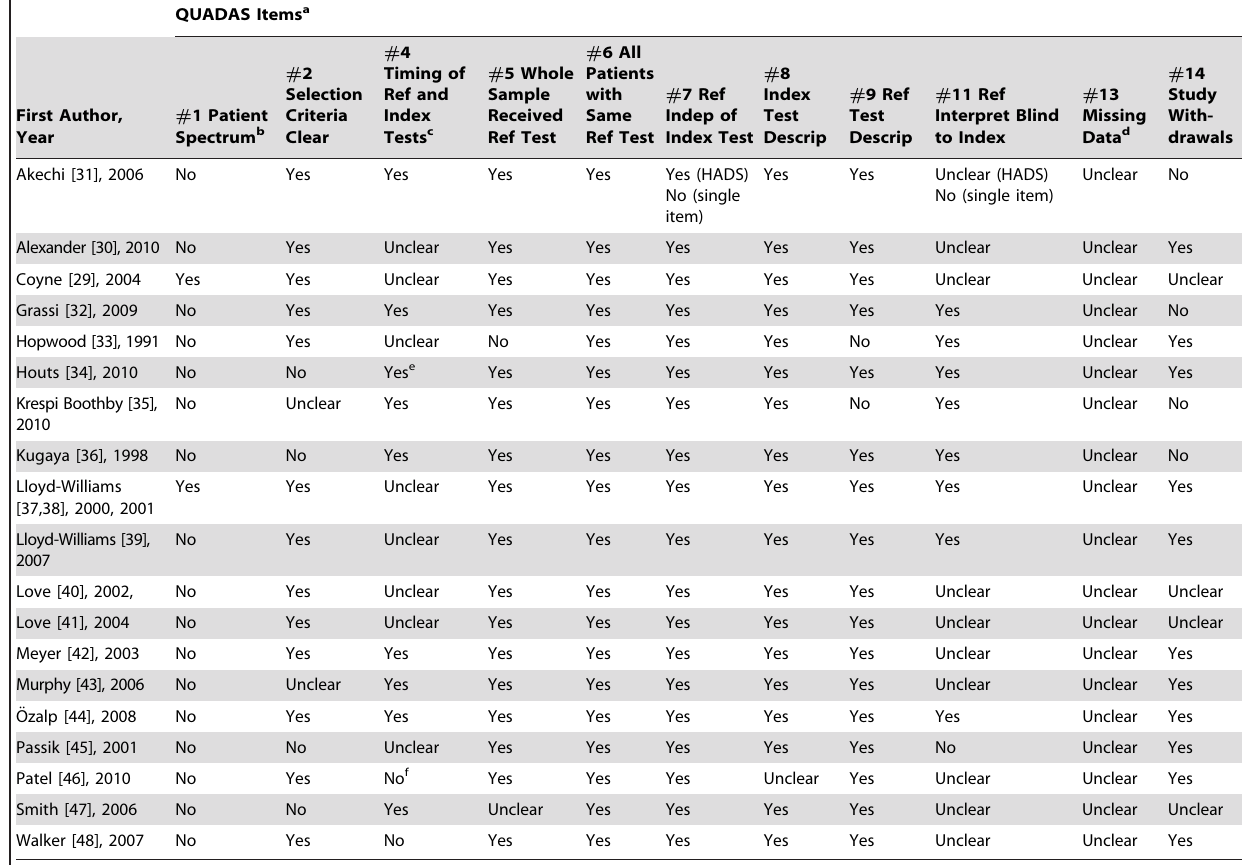
Table 3. Quality Assessment of Studies of Diagnostic Accuracy